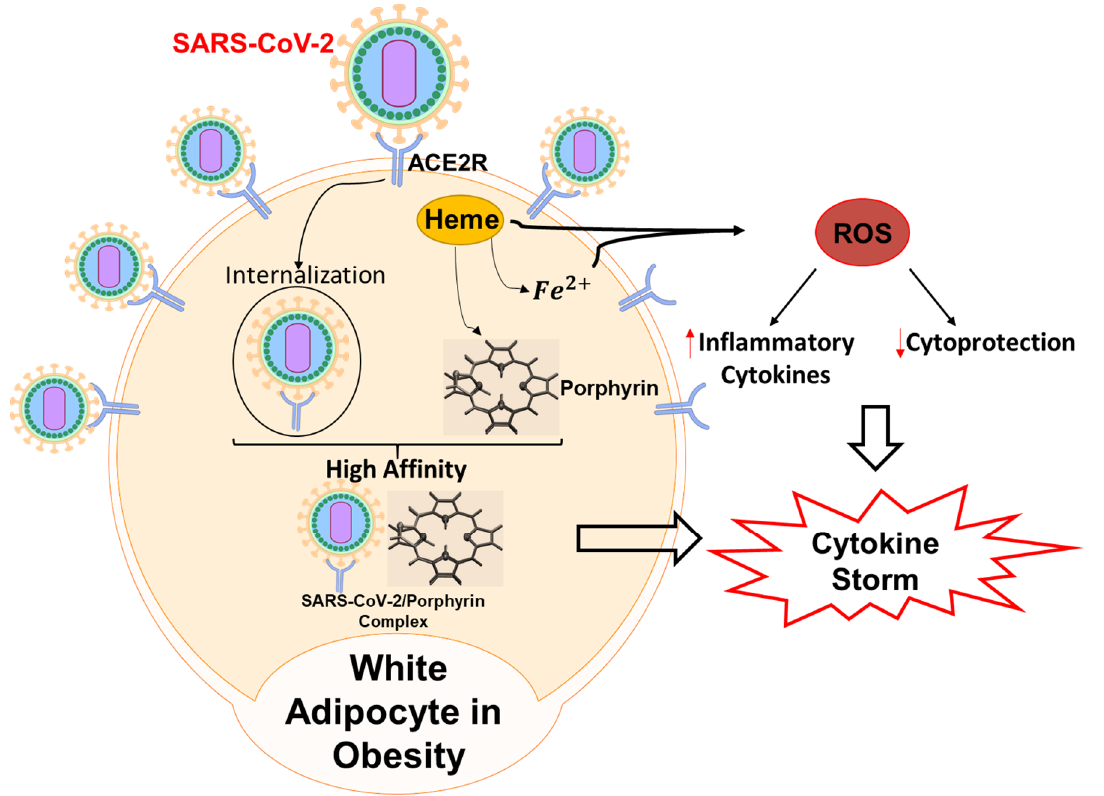
Figure 5. Obesity, COVID-19, ACE-2 receptor and the cytokine storm.